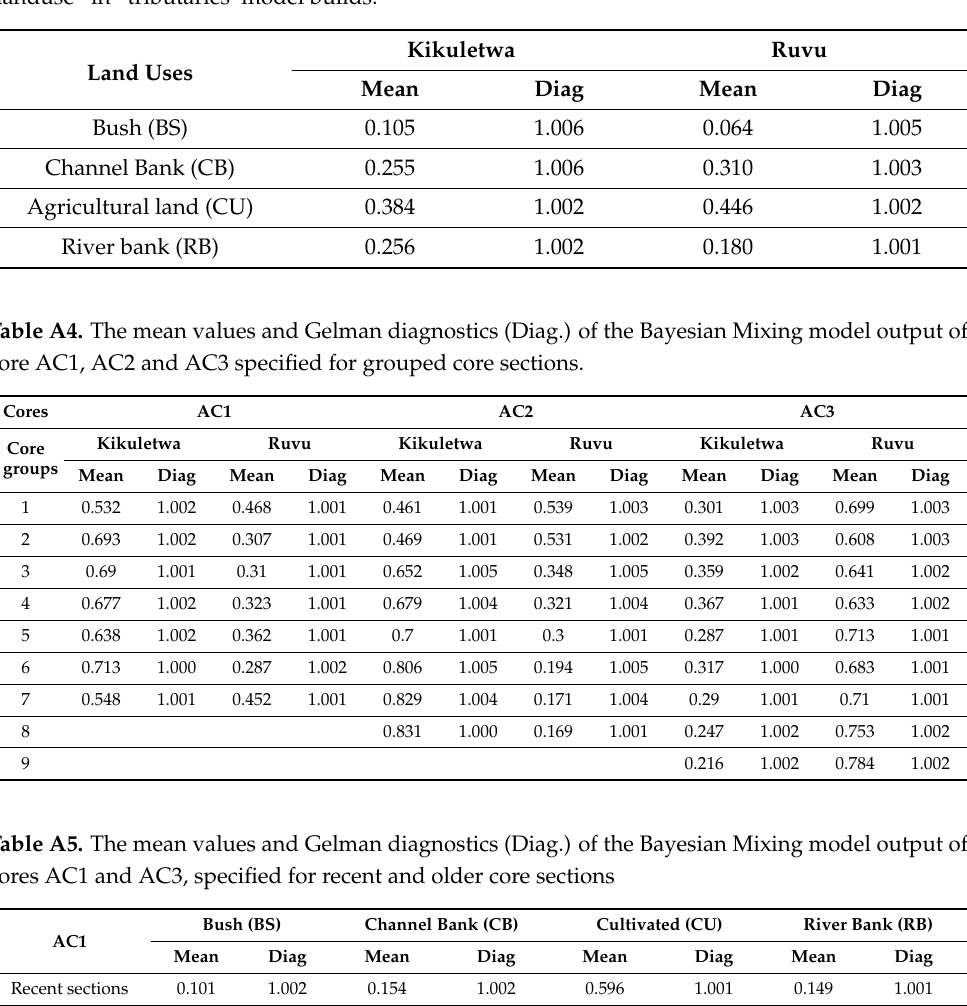
Table A3. The mean values and Gelman diagnostics (Diag.) of the Bayesian Mixing model runs for “landuse” in “tributaries”model builds.